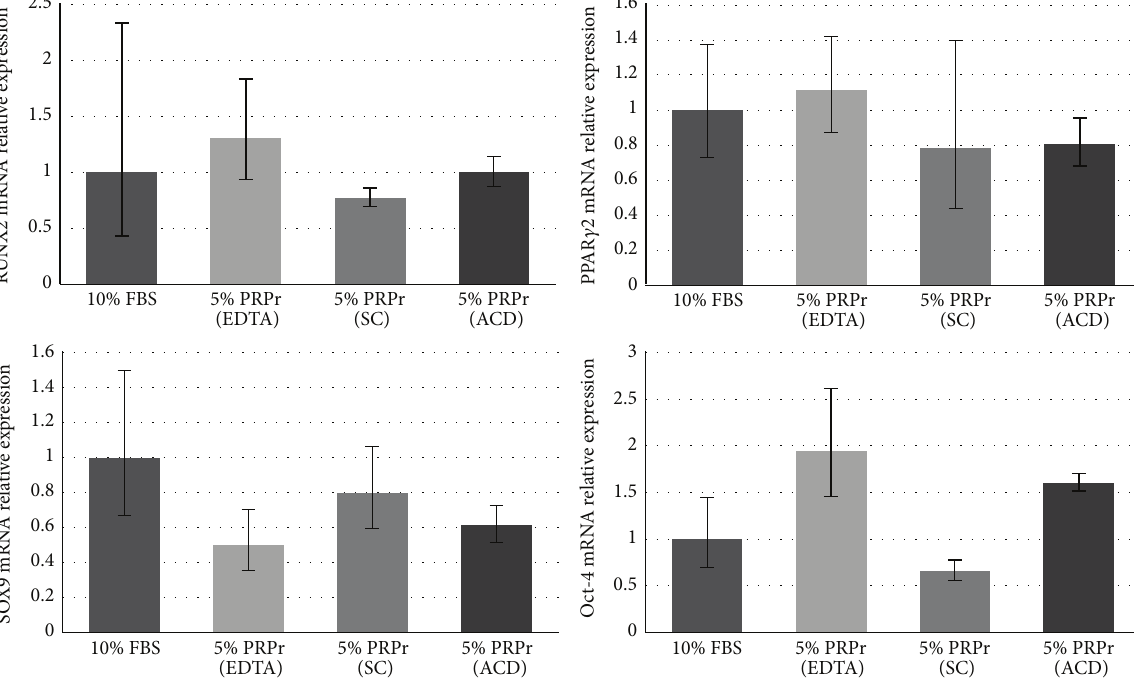
Figure 6: Relative gene expression. RUNX2, PPAR 𝛾 2, SOX9, and Oct-4 gene expression in cells cultured in medium supplemented with 10% FBS (control group) or 5% PRPr obtained with EDTA, SC, or ACD. Data are expressed as relative quantification of gene expression (RQ). Upper and lower error bars correspond to RQ maximum and RQ minimum,